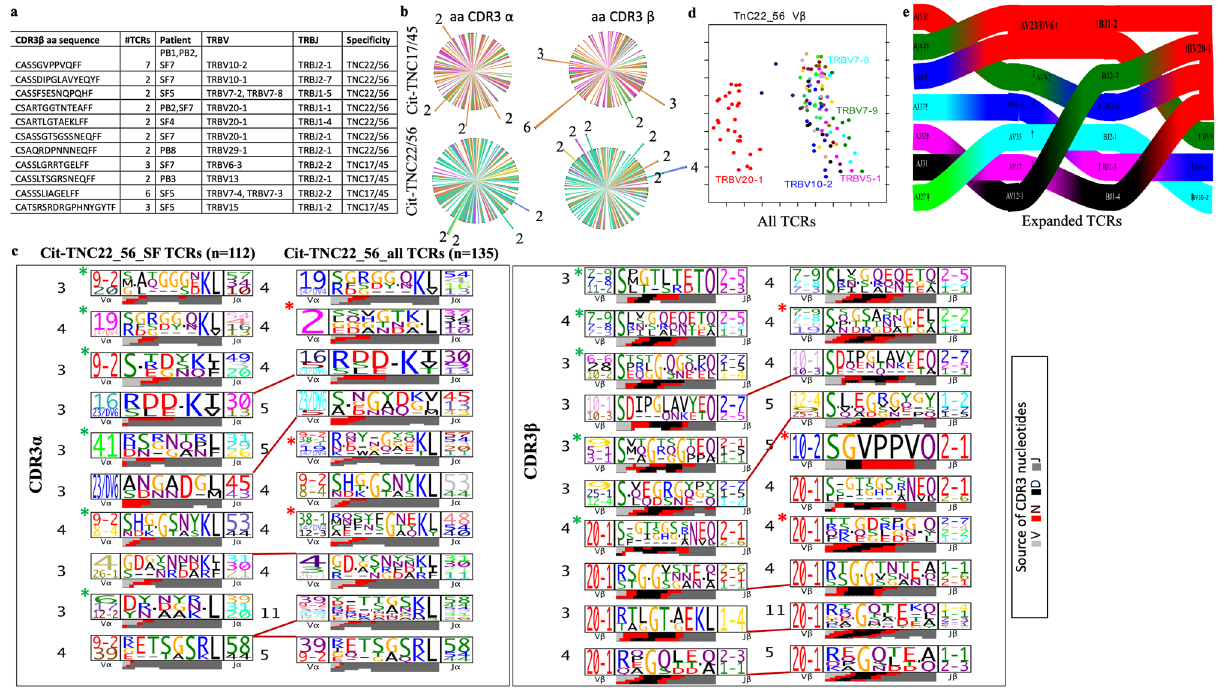
Figure 3. Features of cit-TNC specific TCR repertoire in RA: ( a ) Sharing of amino acid sequences in the TCR- CDR3 beta was found between 3 different patients and within 7/8 patients. Shared TRBV and TRBJ gene usage patterns are shown in the context of the different patient samples and citrullinated antigens. Only cit-TNC22/56 specific CDR3 sequences showed sharing between patients. ( b ) Sharing of exact CDR3α (left column) or CDR3β (right column) amino acid sequences between different TCRs as shown for TNC17/45 sequences (upper row), and TNC22/56 (bottom row). The protruding arms in the figure represent shared TCRs where each color signifies a different sample. ( c ) The figure shows CDR3 consensus sequences (logos) obtained using TCRdist, where amino acids are marked according to their source genes. The first panel shows the comparison of patterns in the CDR3 alpha chain of cit-TNC 22/56 specific repertoire in SF (left column) and all (SF + PB) samples (right column). The second panel shows the patterns in CDR3 beta sequences. For both alpha and beta, the patterns shared between PB and SF of different samples are marked with connecting lines, while SF restricted and PB restricted patterns are marked in green and red asterisks respectively. ( d ) Principal component analysis (PCA) of TRBV gene usage between all cit-TNC22/56-specific TCRs shows differential distribution of TRBV20-1 gene (red) while other gene segments display considerable overlap. ( e ) Paired alpha/beta TCR gene usage patterns of cit-TNC22/56 specific expanded TCRs from the four patients are shown on the right. The gene usage pattern (alpha on the left and beta to the right) show genes in order of their prevalence (top color representing maximum proportion). TRBV20-1 (left side in red) was the most used BV gene and paired gene-usage patterns showed similarities among different cit-TNC22/56-specific TCRs from different RA